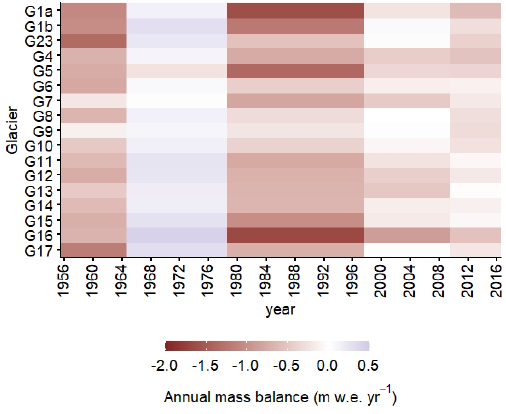
Figure 4. Annual mass balance in mw.e.yr − 1 over the different